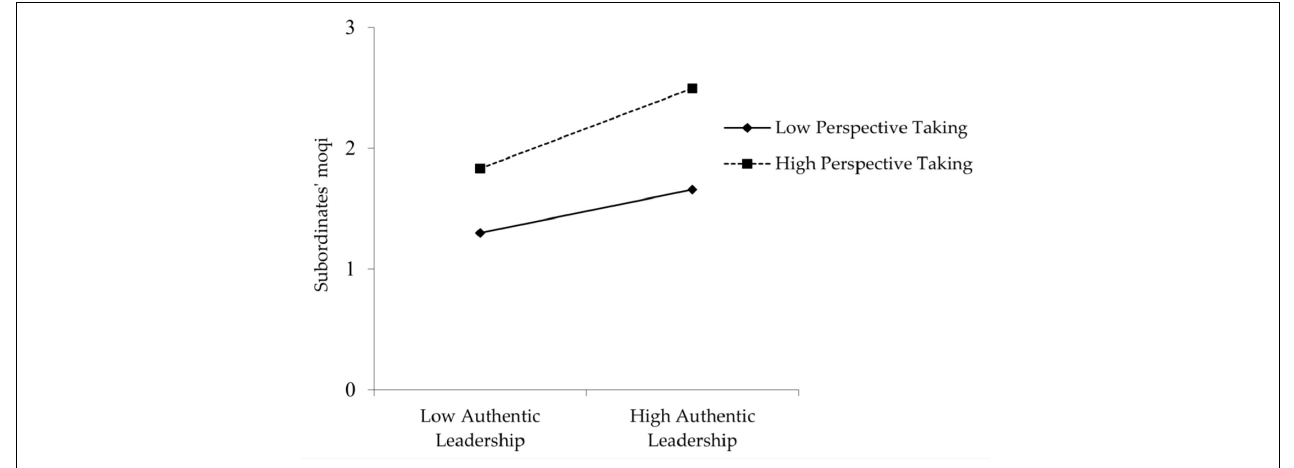
FIGURE 2 | The moderating effect of perspective taking on the relationship between authentic leadership and subordinates’